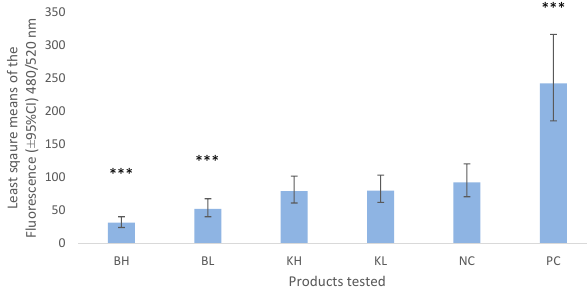
Figure 1. Least square means ( ± 95% CI) of the fluorescence values obtained from chemotaxis assay measured at 480/520 nm wavelength. BH = bismuth high (3% w/v), BL = bismuth low (1.5% w/v), KH keratin high (3%), KL = keratin low (1.5%), NC= negative control (0.5% BSA-RPMI) PC= positive control (FBS). Asterisks show the significance levels of the comparison with the negative control. *** means p -value < 0.001.